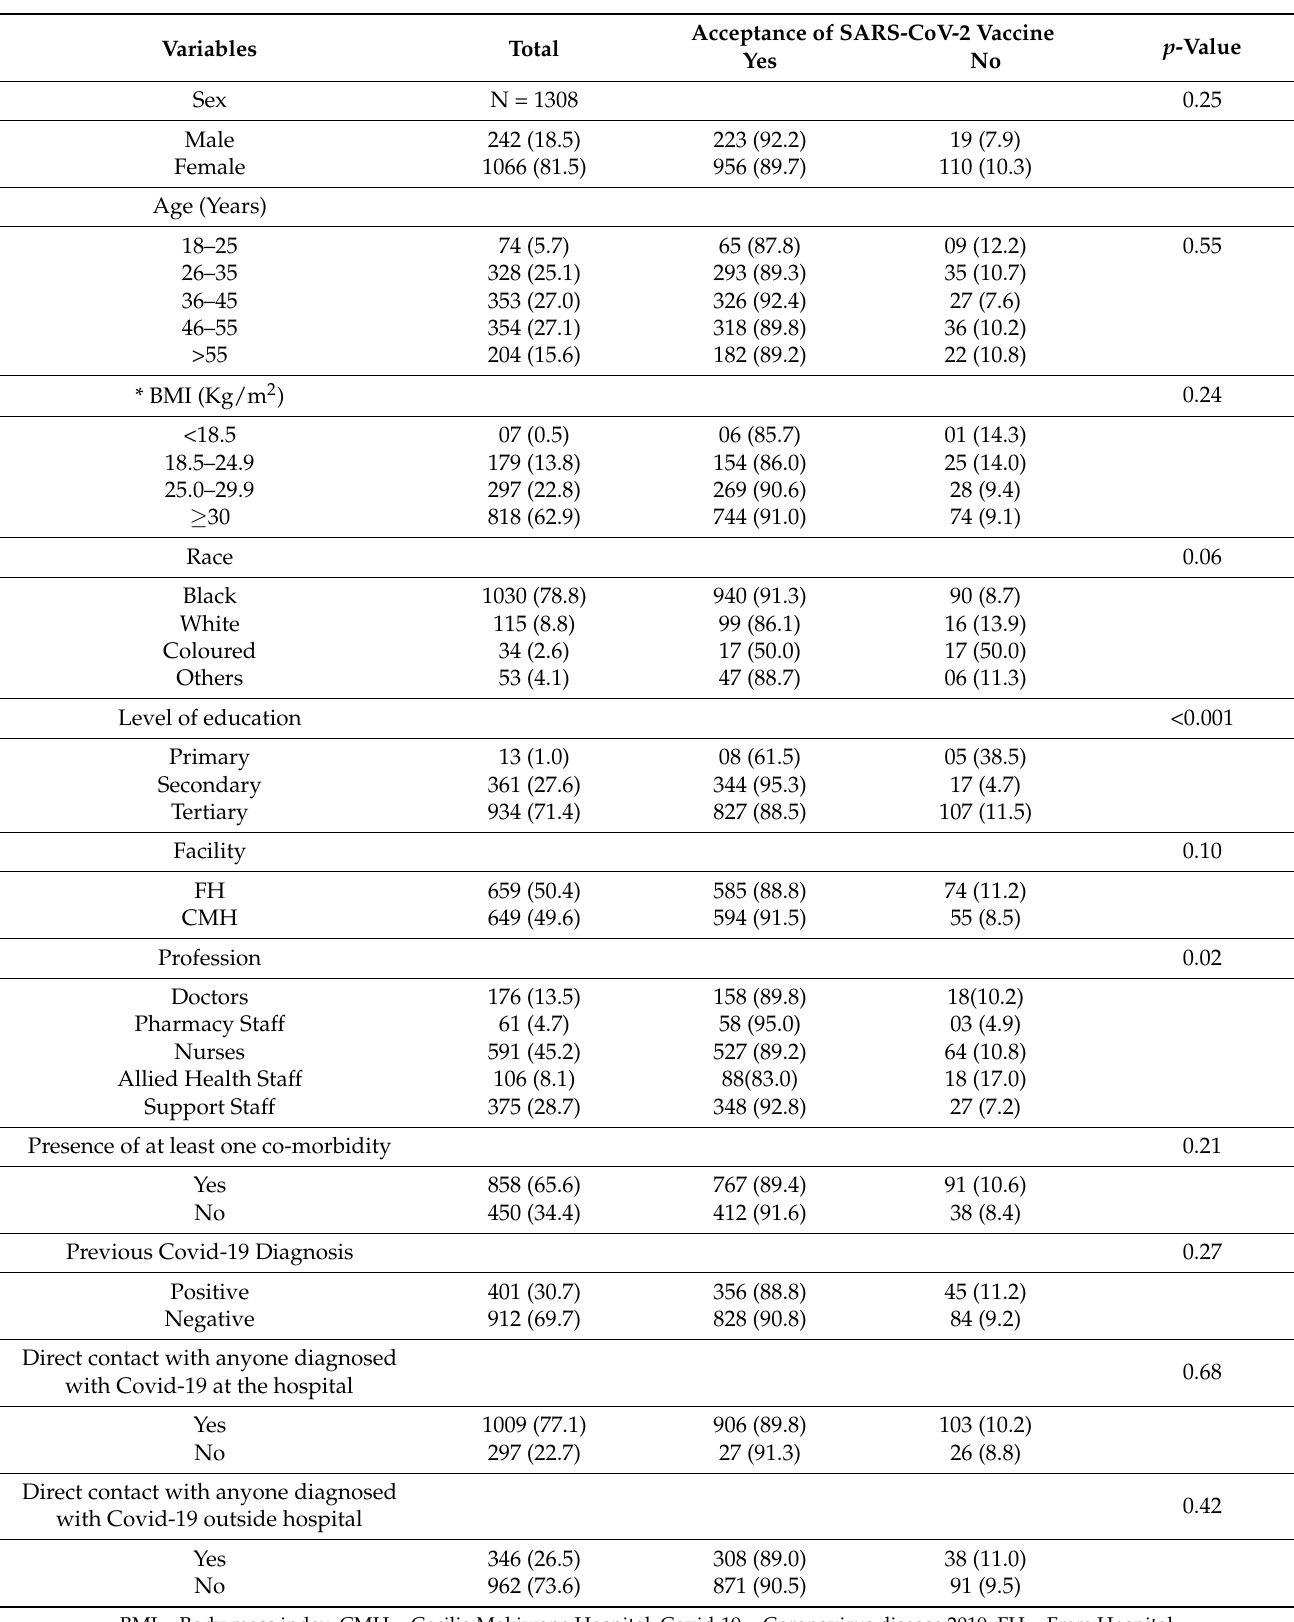
Table 1. Pearson chi-squared test of demographic characteristics of the participants and SARS-CoV-2 vaccine acceptance.